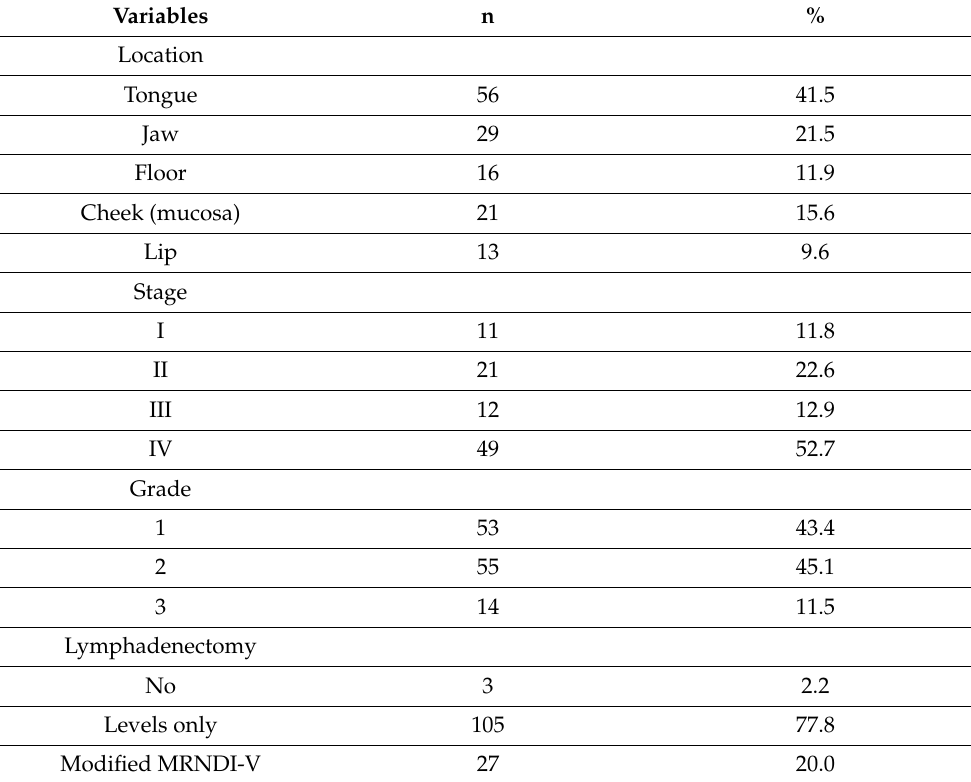
Table 2. Clinical characteristics of the